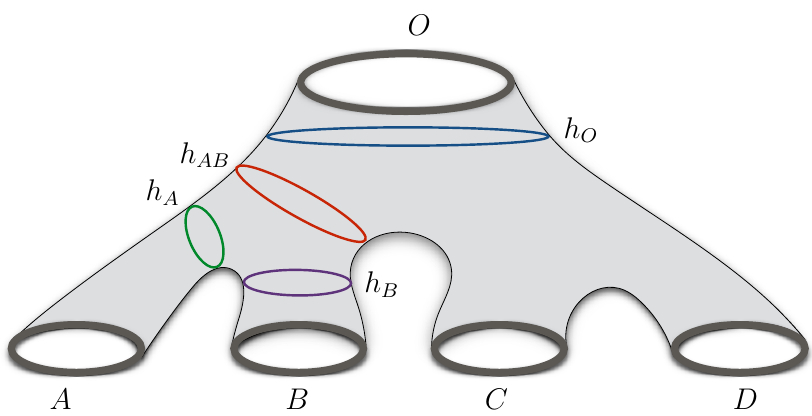
Figure 1 . The geometry (at t = 0) corresponding to the four party extremal ray of interest. The sizes of the horizons and the internal cycles are (cid:12)xed in order to obtain the correct entropies, see the main